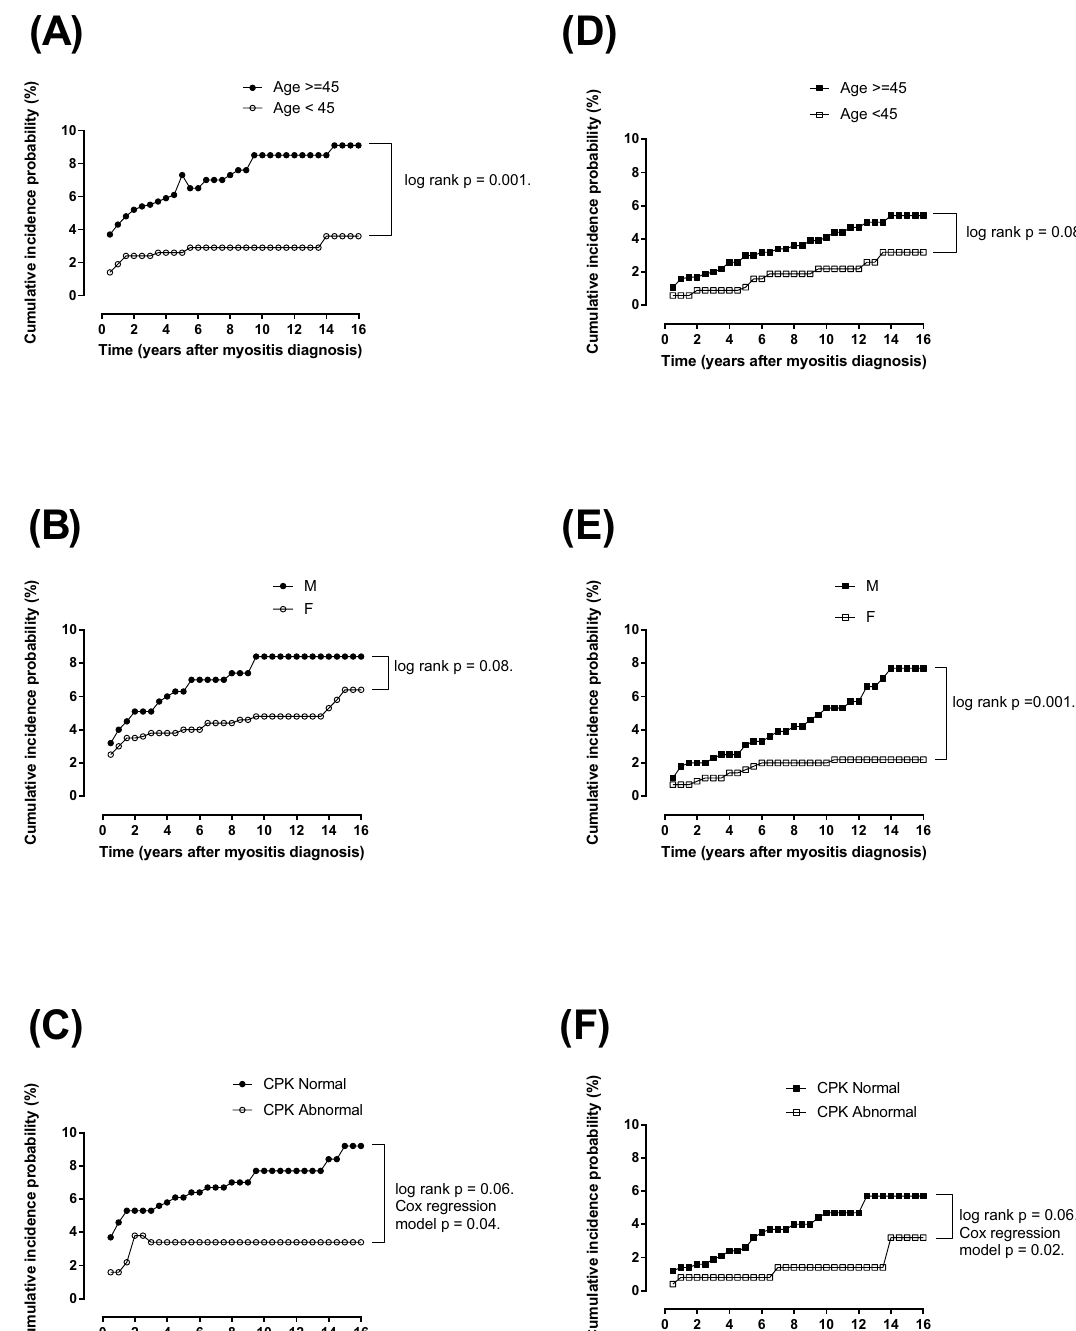
Figure 2. Kaplan–Meier analysis of the malignancy cumulative incidence probability in patients with DM and PM stratified by age, sex and CPK results. Panels ( A )–( C ) show the malignancy cumulative incidence probability stratified by age, sex and CPK results in patients with DM. Age (≥ 45 years old) showed a significantly higher malignancy incidence (log rank p = 0.001). Panels ( D )–( F ) show the malignancy cumulative incidence probability stratified by age, sex and CPK results in patients with PM. Male patients had a significantly higher malignancy incidence (log rank p = 0.001). Although the CPK results did not show significant differences based on Kaplan–Meier analyses in patients with DM and PM, there were significant group differences in multivariate Cox regression models (all p <